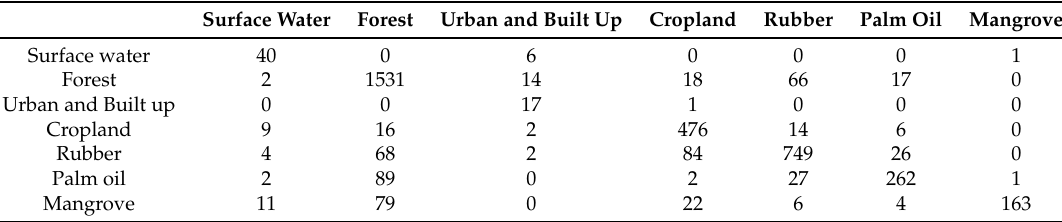
Table 3. Confusion matrix for 2017 and